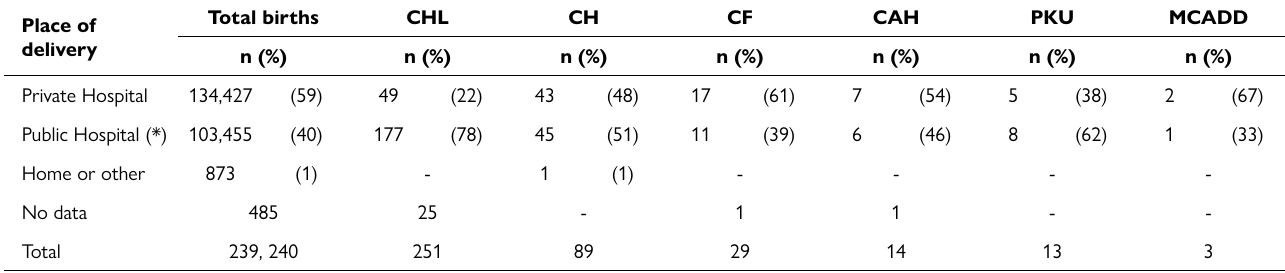
Table 2. Place of delivery of newborns from Newborn and Infant Screening Programme and the total births in Uruguay from 2010 to 2104. Place of delivery